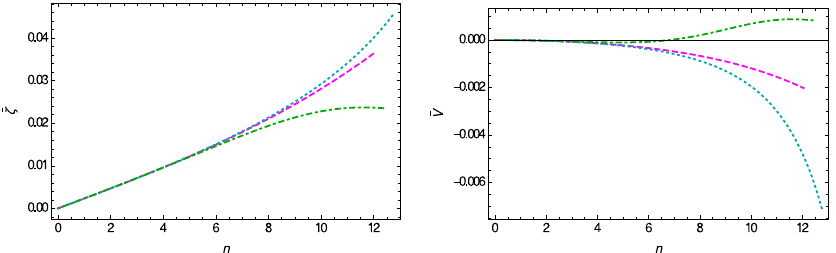
Fig. 26 Variation of the non-zero component of the three-form field ¯ ζ (left panel) and of the Higgs-type potential (right panel) as a function of the radial coordinate η for three-form field Bose–Einstein condensate